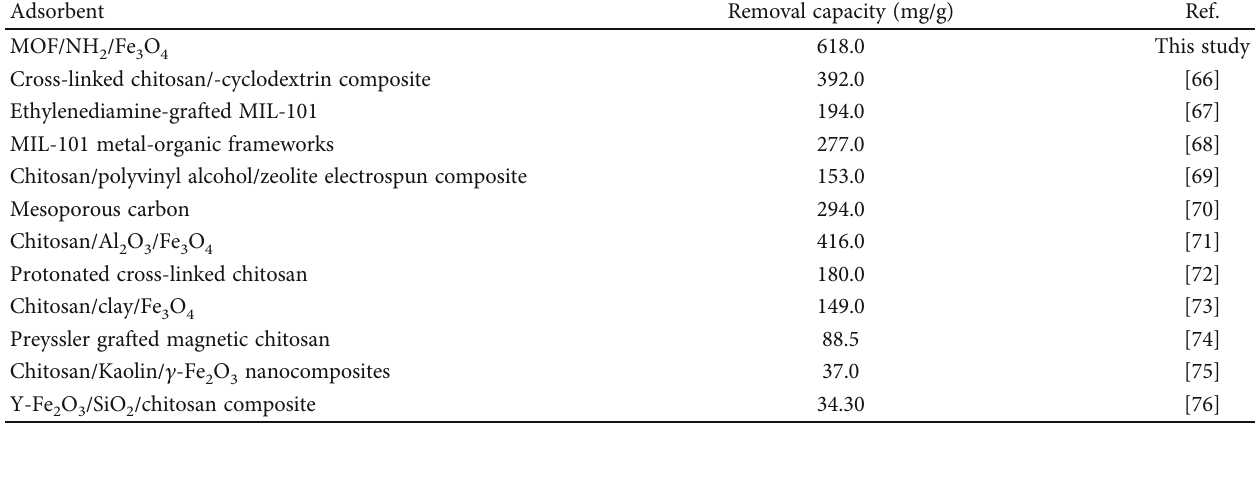
/Fe O composite with previously reported adsorbents for the removal of MO dye. 2 3 4